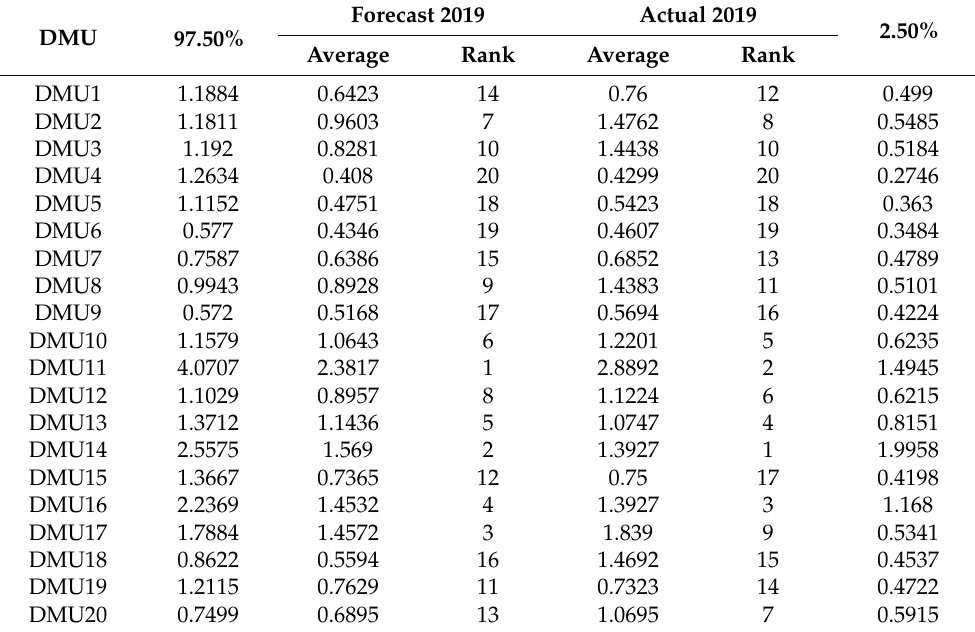
Table 7. Forecast DEA scores, actual (2019), and confidence interval by Lucas weighted